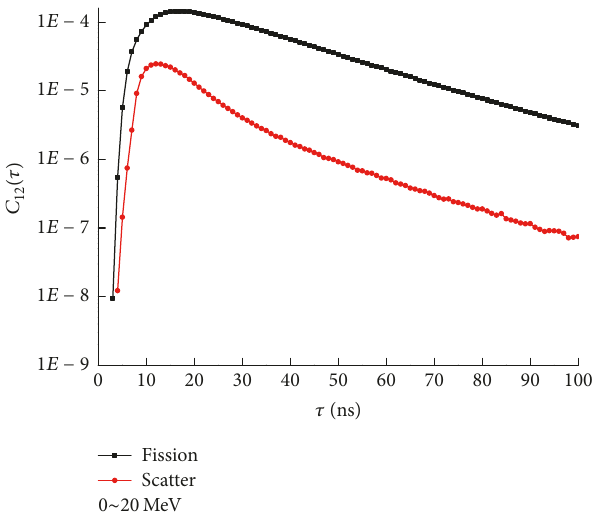
Figure 6: Simulation results of “real” and “accidental” coincidence.